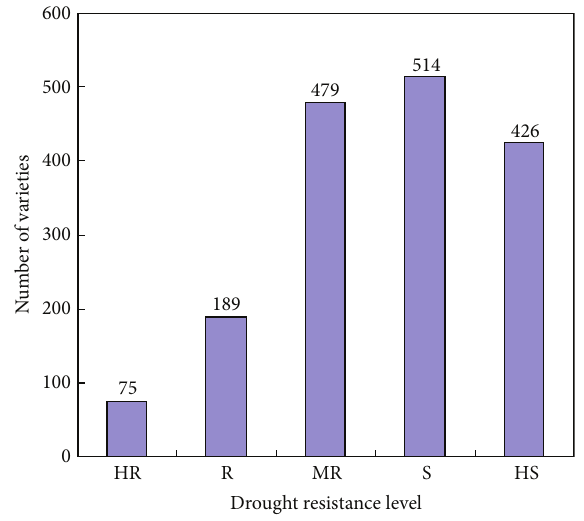
Figure 1: The distribution of 1,683 wheat varieties: HR: high resistant; 𝑅 : resistant; MR: moderate resistant; 𝑆 : susceptible; HS: high